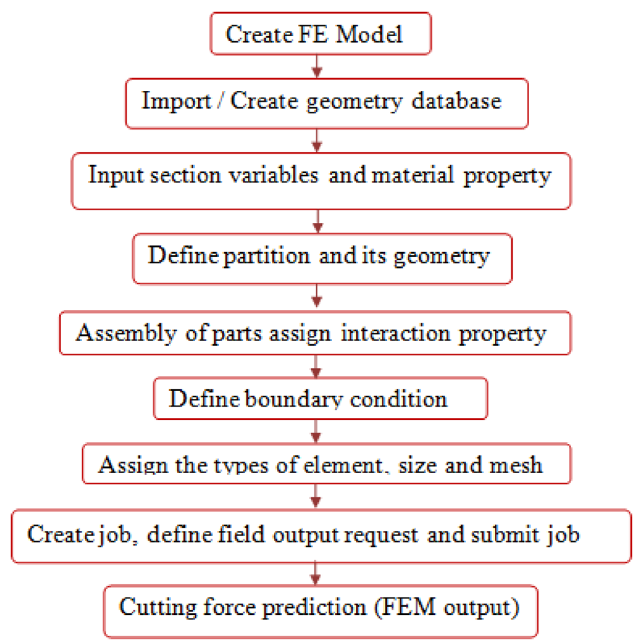
Fig. 2. Finite element model fl owchart to predict the cutting